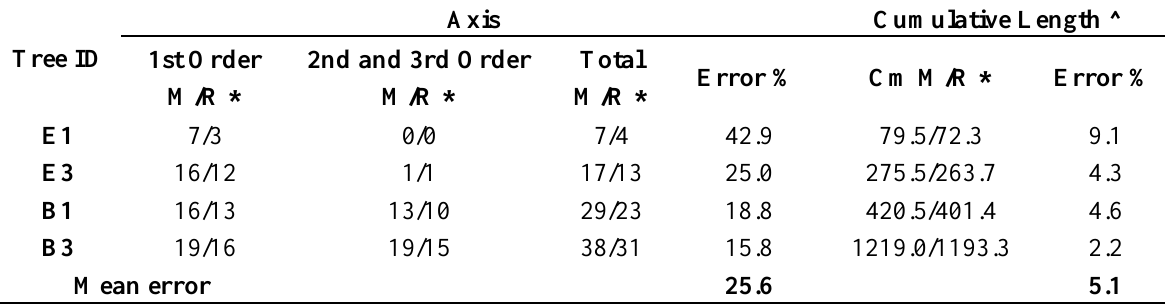
Table 2. Validation results for the automatic reconstruction of 3-year-old sugar maple (E1 and E3) and yellow birch (B1 and B3) saplings that were grown under contrasting light regimes. Axis ordering system is based on Barthelemy and Caraglio